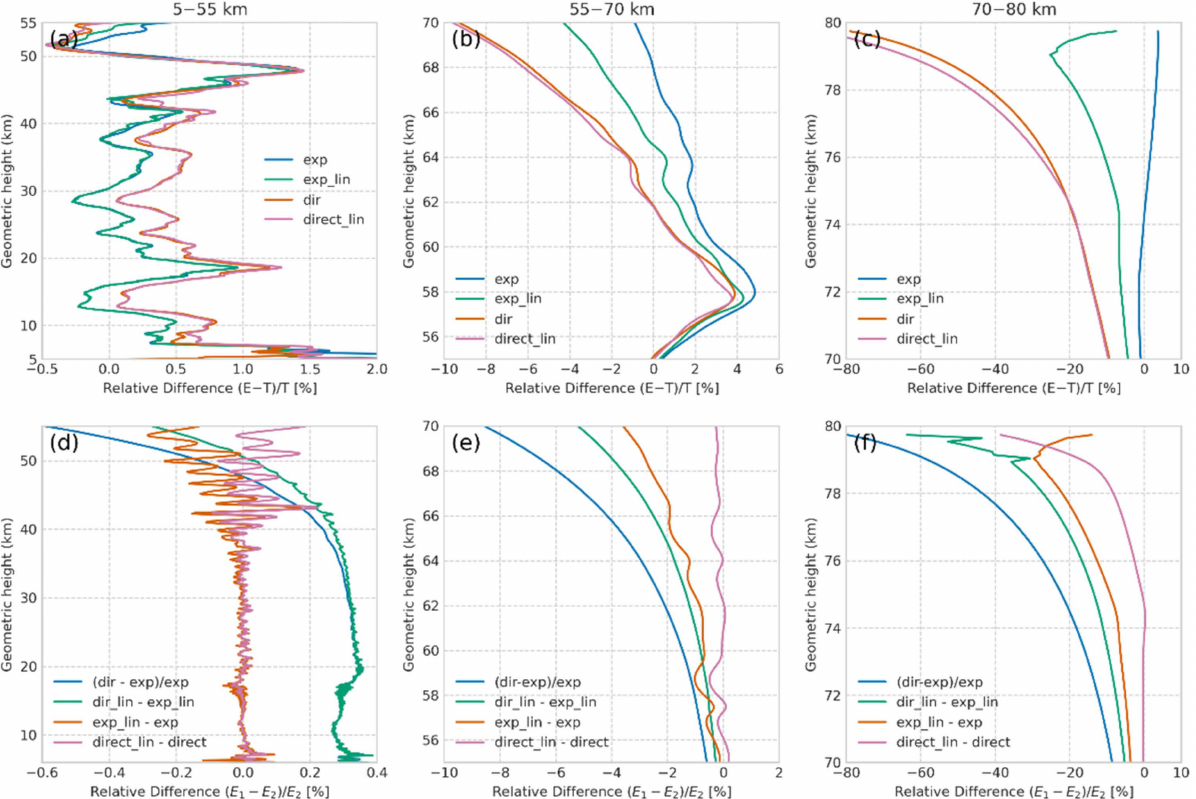
Figure 4. RD of the BAs of FY3D (T) and EC4Dvar (E) based on the direct and exp Abel integral algorithms, with log-linear and log-cubic interpolation methods. ( a – c ) (E − T)/T, where E can be calculated by either the exp or direct algorithm, with both interpolation methods; ( d – f ) (E 1 − E 2 )/E 2 , where 1, 2 indicate two different